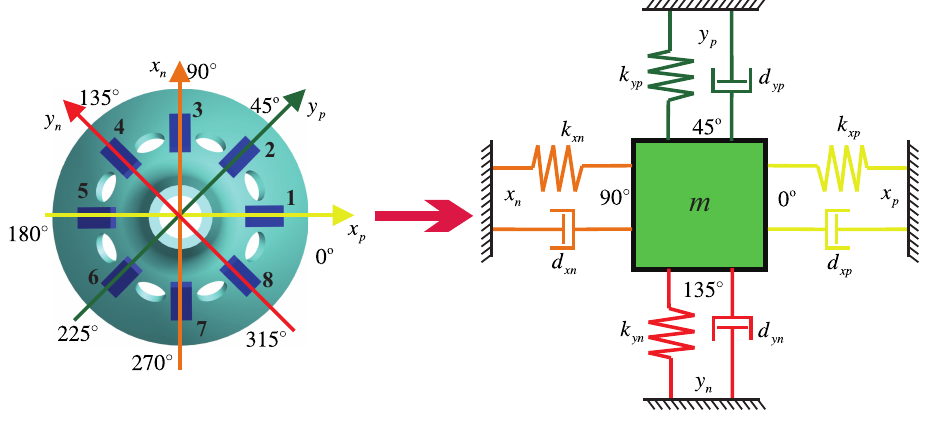
Figure 3. The equivalent vibratory model of the bell-shaped